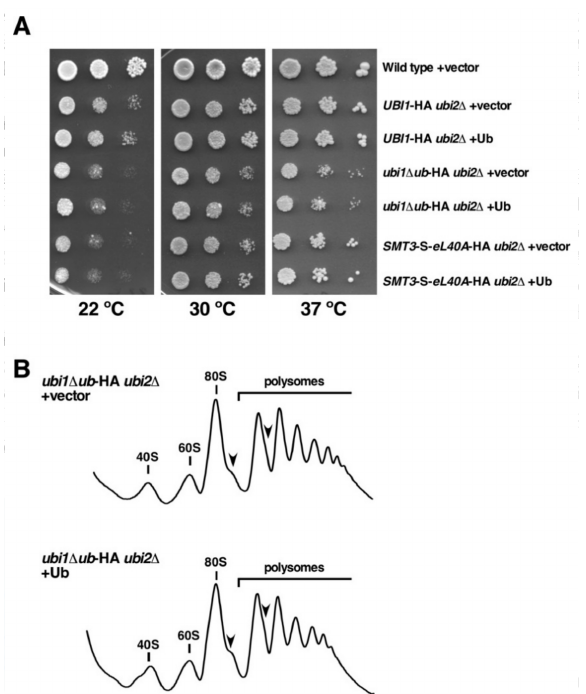
Figure 7. Expression of free ubiquitin in trans does not restore the growth defects of ubi1 ∆ ub -HA ubi2 ∆ or SMT3-S-eL40A -HA ubi2 ∆ cells. ( A ) Growth comparison of the strains W303-1A (Wild type), SMY256 ( UBI1 -HA ubi2 ∆ ), SMY257 ( ubi1 ∆ ub -HA ubi2 ∆ ), and SMY258 ( SMT3 - S - eL40A -HA ubi2 ∆ ) transformed with either empty YCplac111 (vector) or pADH111-Ub (Ub), a YCplac111-based plasmid expressing ubiquitin from the strong ADH1 promoter. Transformants were selected on SD-Leu plates and then spotted in fivefold serial dilution steps onto SD-Leu plates, which were incubated for 4 days at 22 ◦ C, for 3 days at 30 ◦ C, and for 2 days at 37 ◦ C. ( B ) Polysome profile analysis of ubi1 ∆ ub -HA ubi2 ∆ cells harboring either empty YCplac111 (vector) or pADH111-Ub (Ub). Cells were grown in SD-Leu at 30 ◦ C to an OD 600 of about 0.8. Cell extracts were prepared and 10 A 260 units of each extract were resolved in 7–50% sucrose gradients. The A 254 was continuously measured. Sedimentation is from left to right. The peaks of free 40S and 60S r-subunits, vacant 80S ribosomes / monosomes, and polysomes are indicated. Half-mer polysomes are labeled by